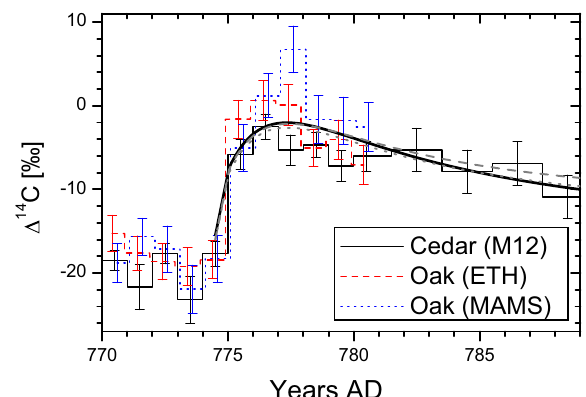
Fig. 24 Time profiles of the measured Δ 14 C content in Japanese cedar (M12—Miyake et al. 2012) and German oak (ETH Zürich & Mannheim AMS—Usoskin et al. 2013) trees for the period around 775 AD. Smooth black and grey lines depict a family of best fit Δ 14 C profiles, calculated using a family of realistic carbon cycle models for an instantaneous injection of 14 C into the stratosphere (Usoskin and